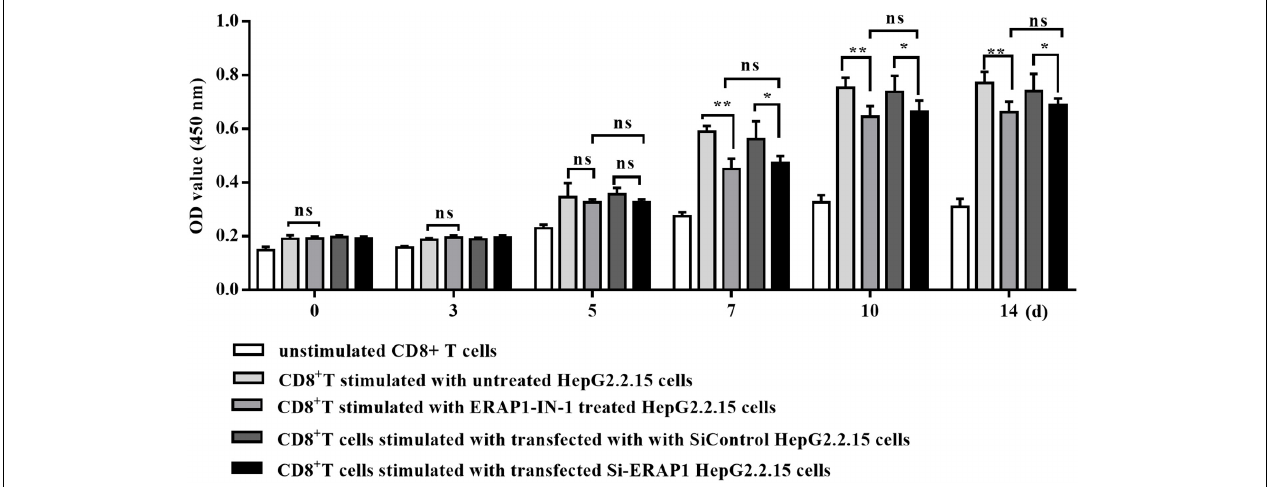
FIGURE 2 | ERAP1-IN-1 or EARP1 knockdown restrains the stimulating ability of HepG2.2.15 cells to CD8 + T cells. HepG2.2.15 cells were pretreated with ERAP1-IN-1 (50 µ m) for 72 h, or siERAP1 HepG2.2.15 cells were treated with mitomycin C (10 µ g/ml) for further 2.5 h and then co-cultured with isolated CD8 + T cells (1:10). The proliferation of CD8 + T cells was detected by CCK-8 (OD 450 nm) 0, 3, 5, 7, 10, and 14 days later after co-culturing. ERAP1-IN-1 untreated or mock HepG2.2.15 cells were used as stimulator control, and unstimulated CD8 + T cells were used as negative control. ns, no significance; * P < 0.05; ** p < 0.01.